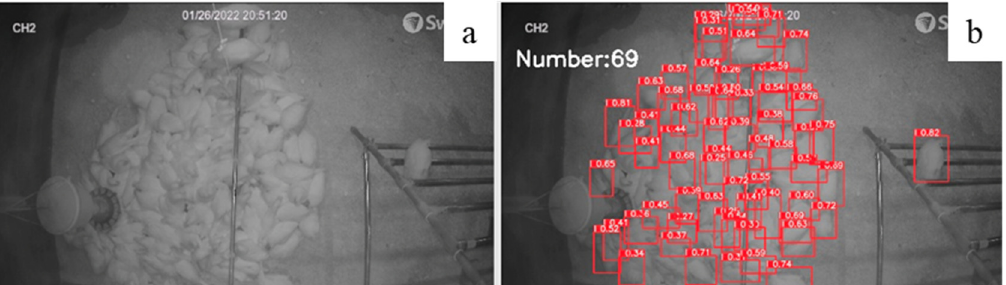
Figure 8. Number of chickens identified under high density by our model: original image of high density ( a ) vs. identified high density ( b ).